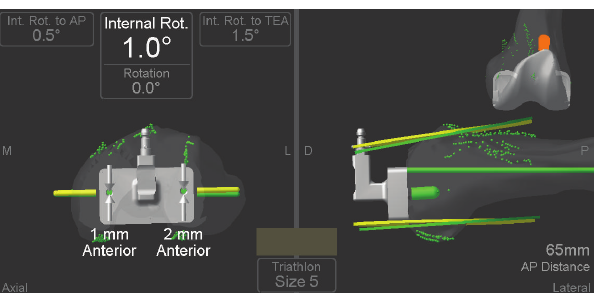
Figure 3: Stryker navigation results including internal rotation according to AP and TEA and average of the two.